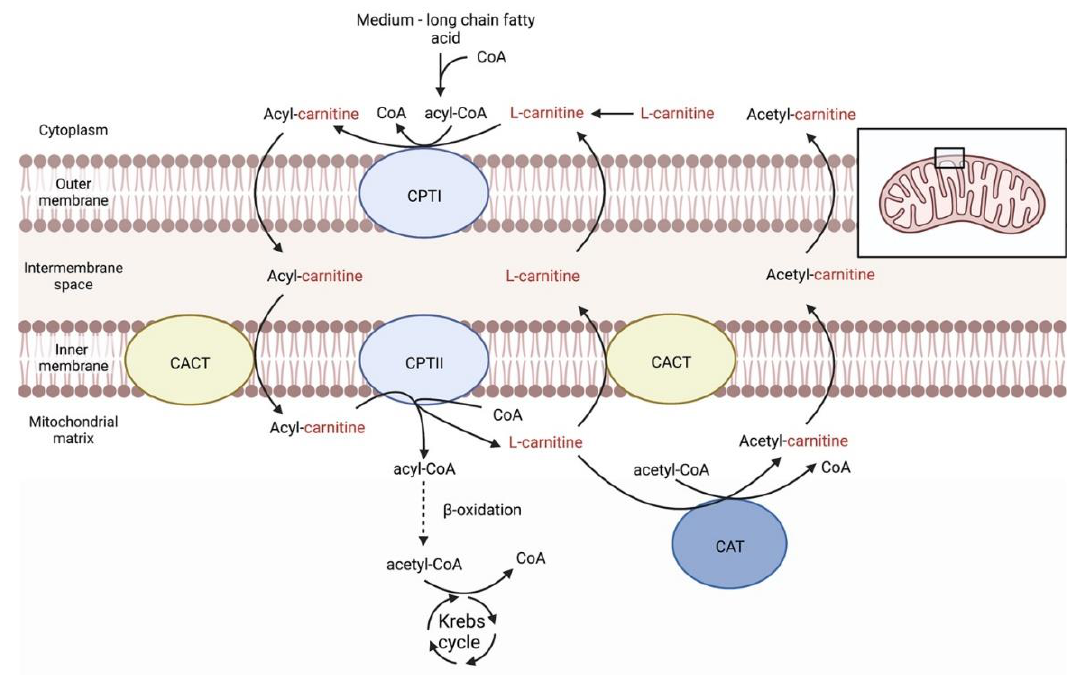
Figure 2. Carnitine shuttling system in eye tissues. L-carnitine seems to play an important role